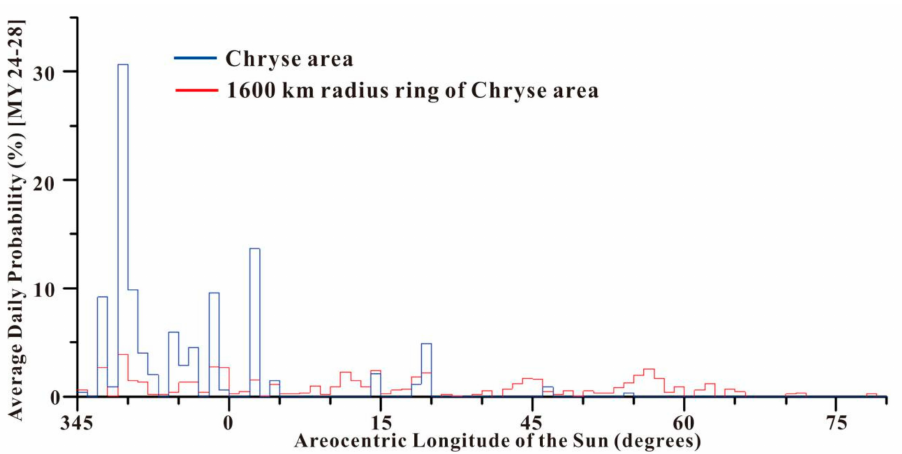
Figure 8. Daily mean dust storm probability in the Chryse landing area (blue color) and within its 1600 km-radius ring (red color) between Ls = 345 and 65 ◦ (EDL season) with the increment of Ls = 1 ◦ . (1) As shown in Figure 8, the P ( T )of the MOC MDGMs of MY 24-MY 28 in Chryse (blue color) peaked at 30.6% (Ls = 348 ◦ ) during EDL season. The dust storm activity in Ls = 345–3 ◦ , with an average P ( T ) of 4.8%. After this, the dust storm activity recurred